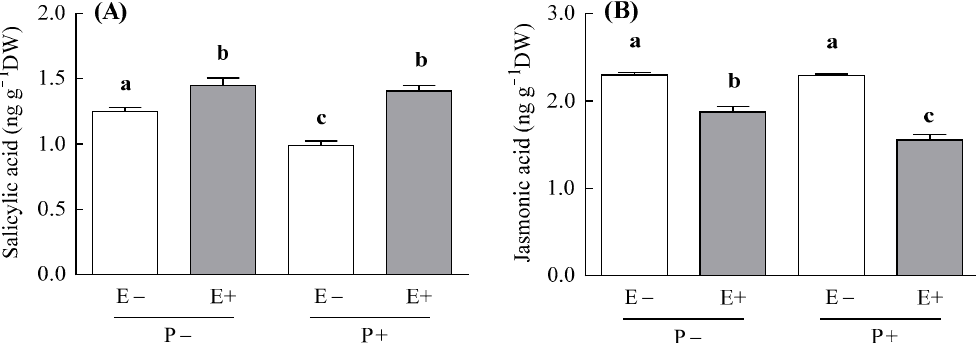
Figure 1. Concentration of the salicylic acid (panel A ) and jasmonic acid (panel B ) hormones of Achnatherum inebrians plants with (E+, shaded bars) and without (E − , unshaded bars) the fungal endophyte Epichloë gansuensis and inoculated (P+) and non-inoculated (P − ) with the pathogen Blumeria graminis . Concentrations were measured at four weeks after the pathogen inoculation of plants. Different letters indicate significant differences at p < 0.05. Bars represent means values ± SEM ( n =